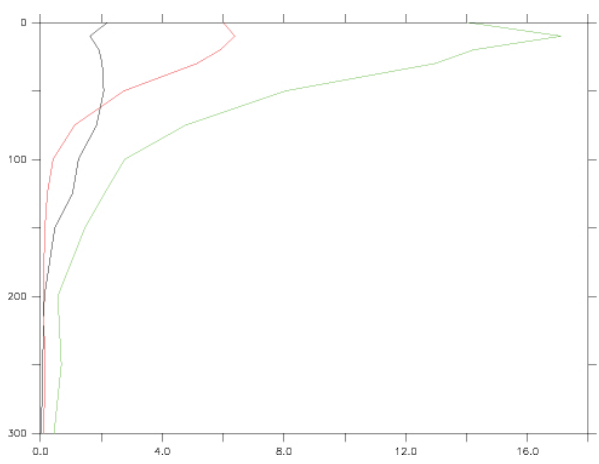
Figure 5. Average depth profiles of Prochlorococcus (black), Syne- chococcus (red) and picoeukaryotes (green) biomass [ µ gCl − 1 ].